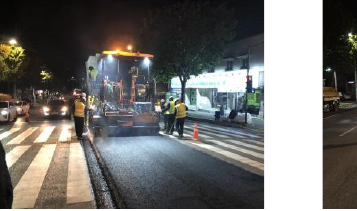
Figure 9. FWD test process.